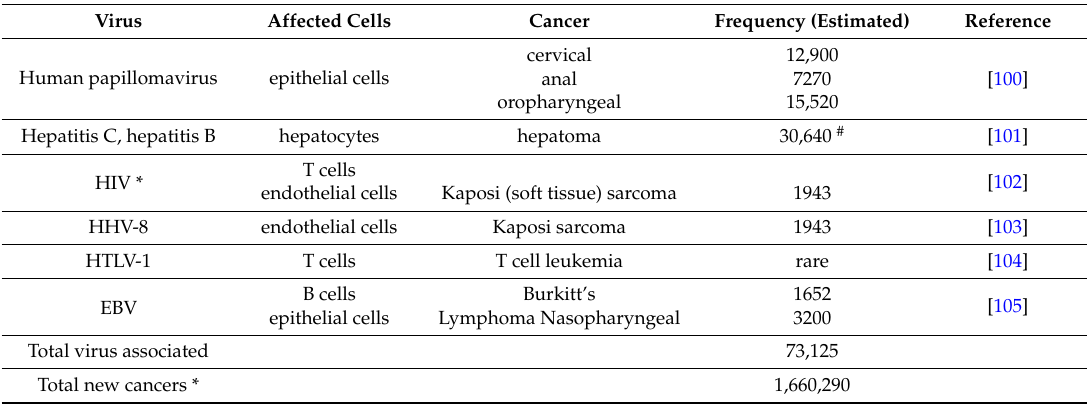
Table 3. Frequency of cancers associated with human oncogenic viruses that can induce cell fusion [27,99] +